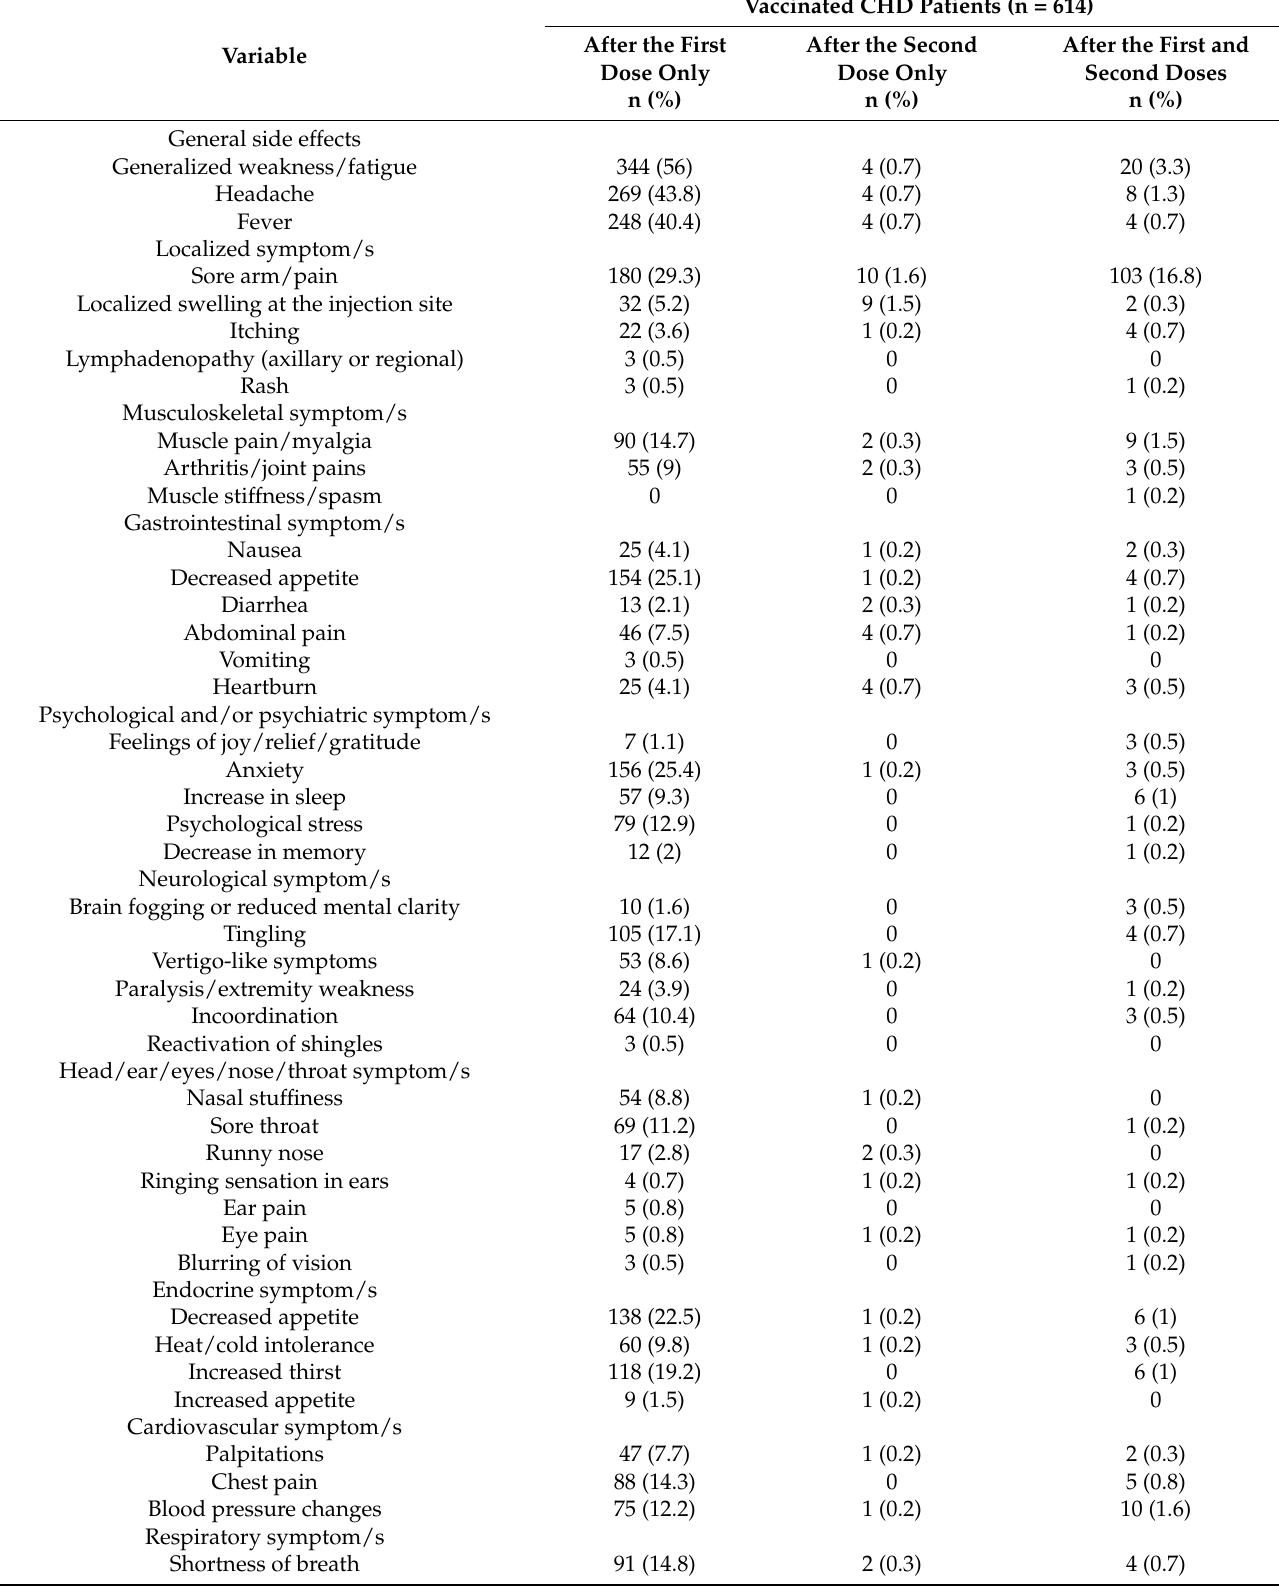
Table 3. Event rate of adverse events associated with COVID-19 vaccination in the vaccinated CHD patients (n =